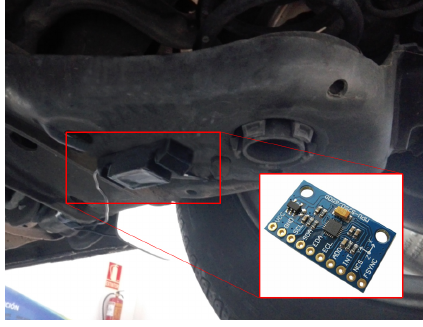
Figure 3. Location of the measuring system.